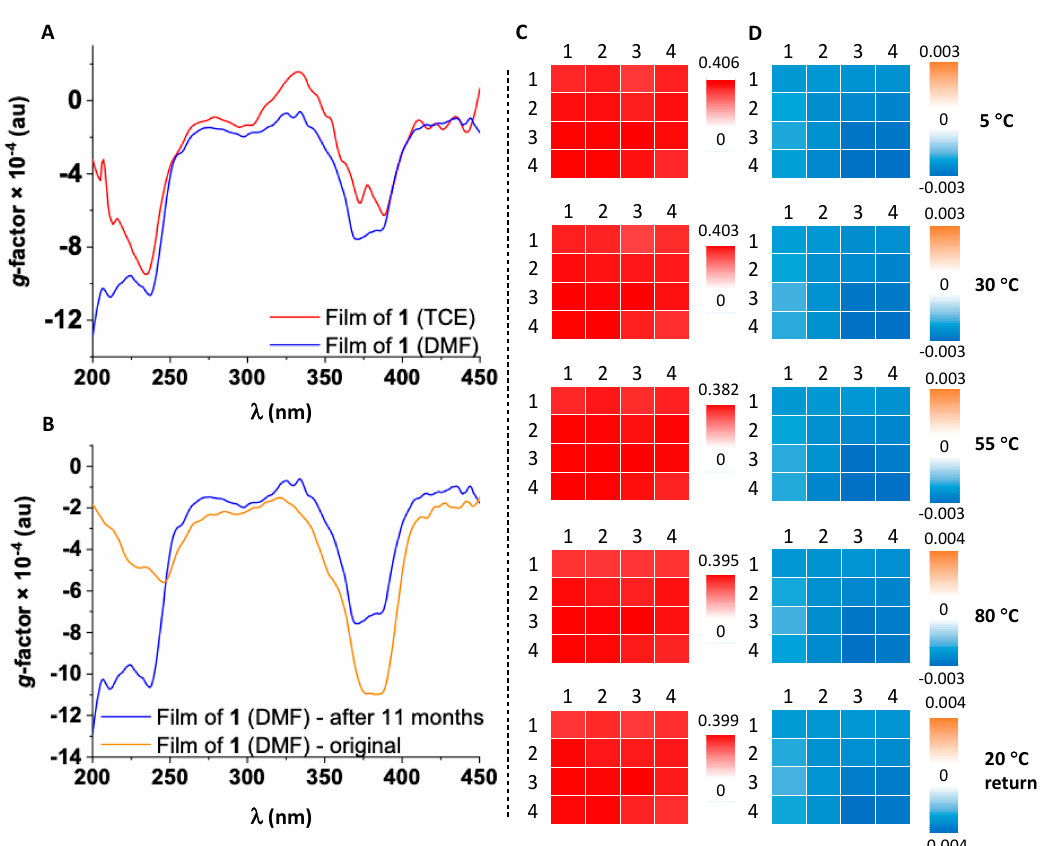
Figure 2. ( A ) Overlaid local dissymmetry g -factor spectra of thin films of 1 from 1,1,2,2-tetrachloroethane (TCE, red line) and N , N -dimethylformamide (DMF, blue line); ( B ) Overlaid local dissymmetry g -factor spectra of thin film of 1 freshly made from DMF (orange line) and the same film after kept 11 months at room temperature (blue line); ( C ) variable temperature (VT) ultraviolet–visible (UV–vis) absorption 2D maps of thin film of 1 ; ( D ) VT dissymmetry g -factor 2D maps of thin film of 1 at the specified temperatures. The data was generated by circular dichroism imaging (CD i ): 4 × 4 grid array area of 1 mm step size with a beam diameter of about 0.05 mm at 387 nm.